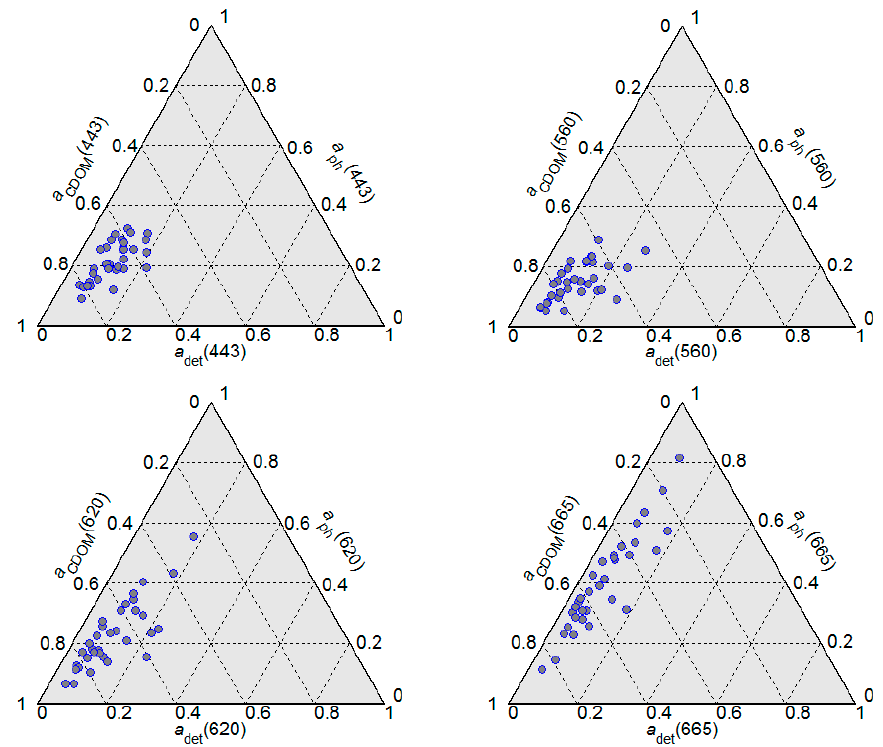
Figure 3. Ternary plot showing the relative contributions of CDOM, detritus, and phytoplankton pigments to the total non - water absorption coefficient at 443 nm, 560 nm, 620 nm, and 665 nm for the investigated area. Note that in the red part of the spectrum, the phytoplankton absorption shows a much greater range than in the blue part of the spectrum and its relative importance increases when compared to CDOM and detrital absorption.